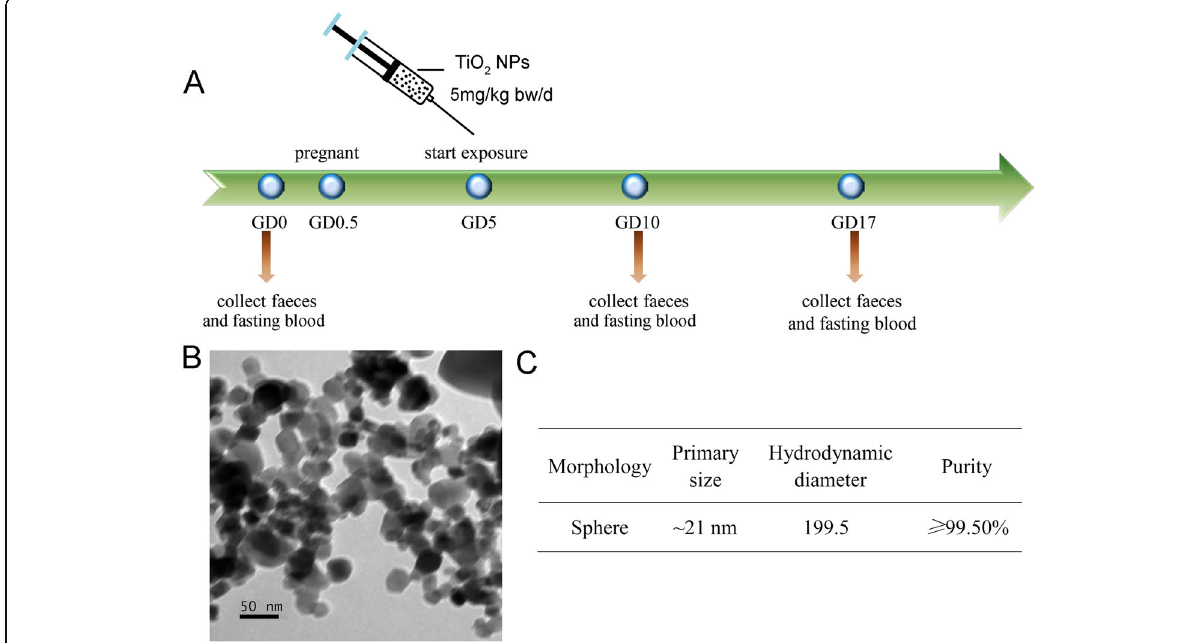
Fig. 1 a The experimental design of this study. b The TEM images of TiO 2 NPs, bar = 50 nm. c Main characteristics of TiO 2 NPs measured or reported by manufacturer were